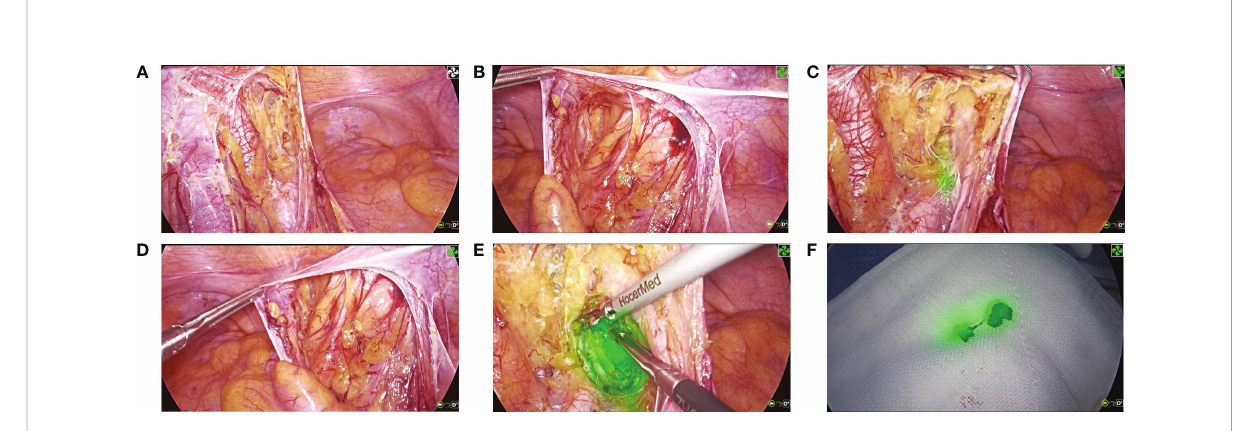
FIGURE 2 4K fl uorescence laparoscopic surgical procedure. (A) Expose the region of the left iliac vessel. (B) Expose the region of the right iliac vessel. (C) Positive ICG- fl uorescent staining of the left LLNs. (D) Negative fl uorescent staining of the right LLNs. (E) Dissect the left LLNs. (F) Specimen of the left